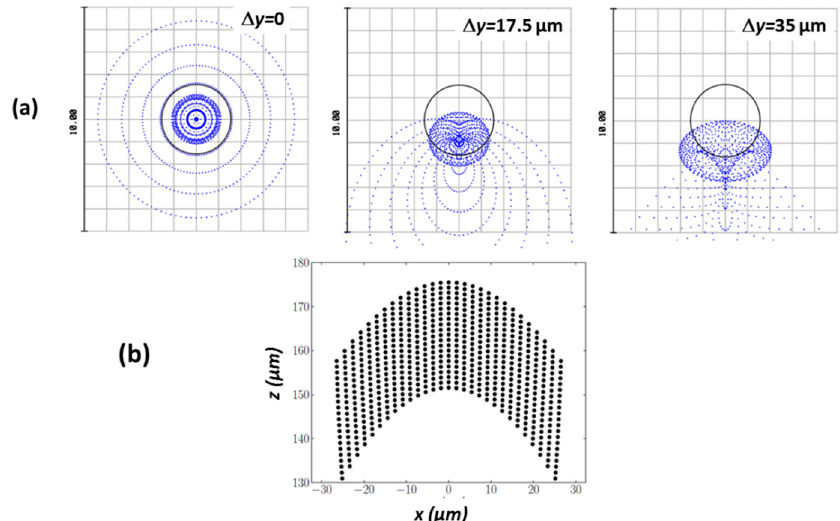
Figure 3. Optical performance of glass-ball microscanner: ( a ) spot diagrams for different lateral displacements of Δ y = 0 µm, 17.5 µm, 35 µm; and ( b ) shape of scanning volume (adjacent points correspond to the scanning lenses displaced by 2 µm in two considered ( x , z ) directions). Reproduced with permission from [13], published by OSA Publishing, 2015.